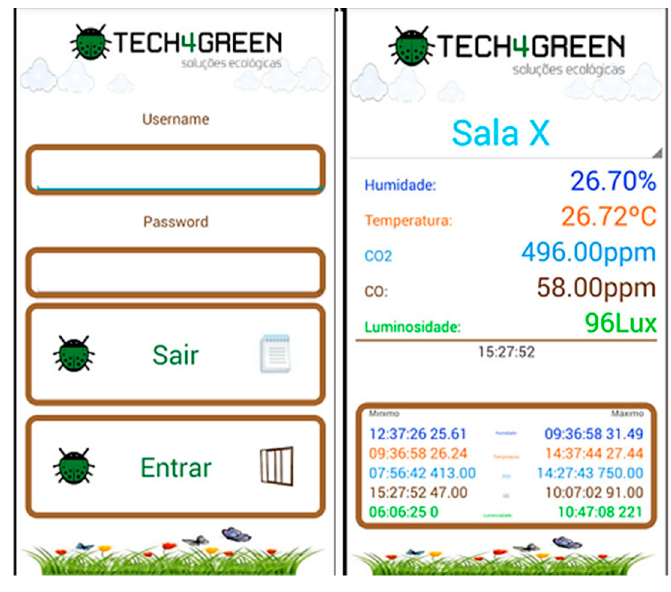
Figure 4. Android app.